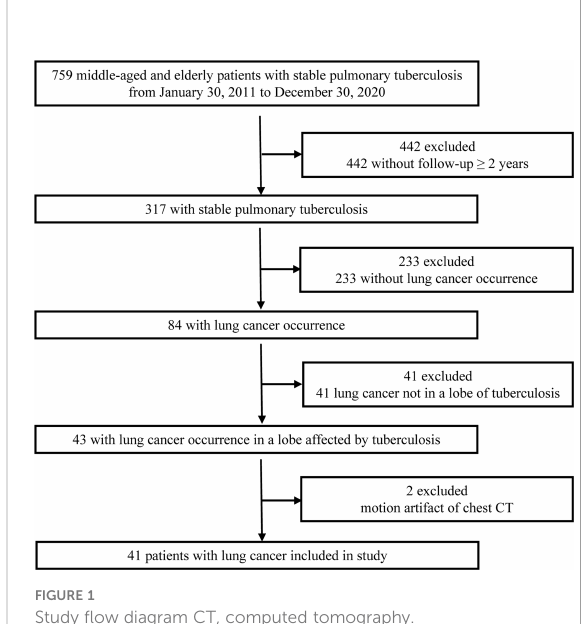
FIGURE 1 Study fl ow diagram CT, computed